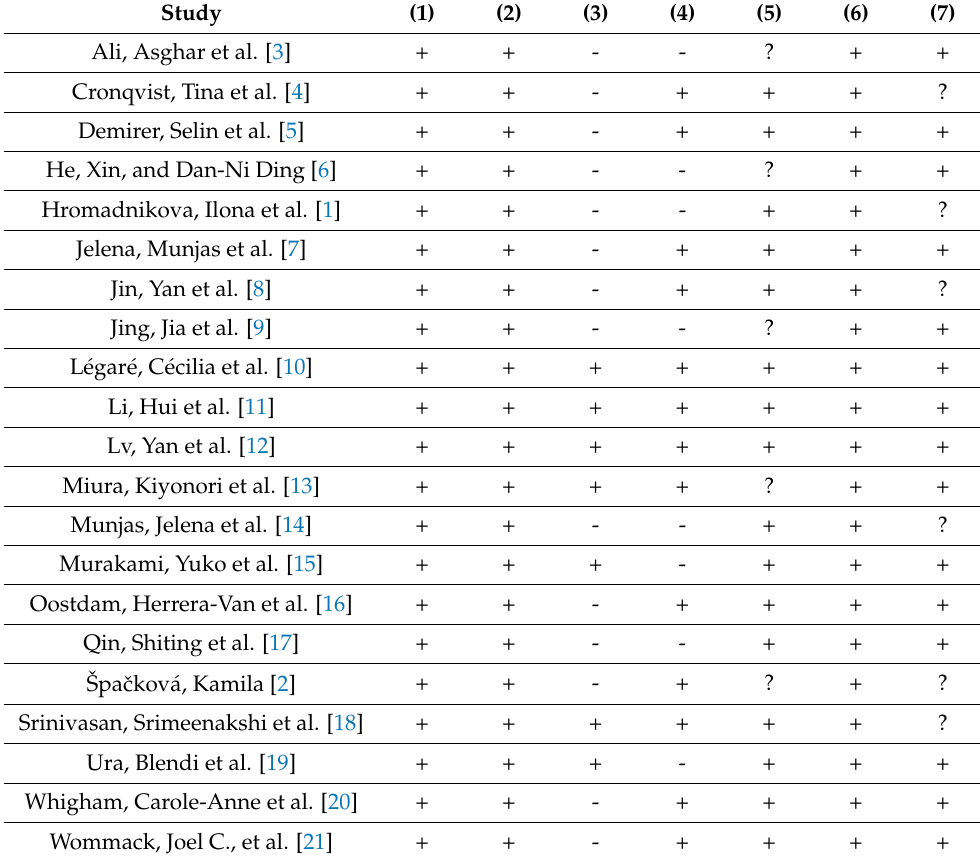
Table 2. Cochrane Bias Risk